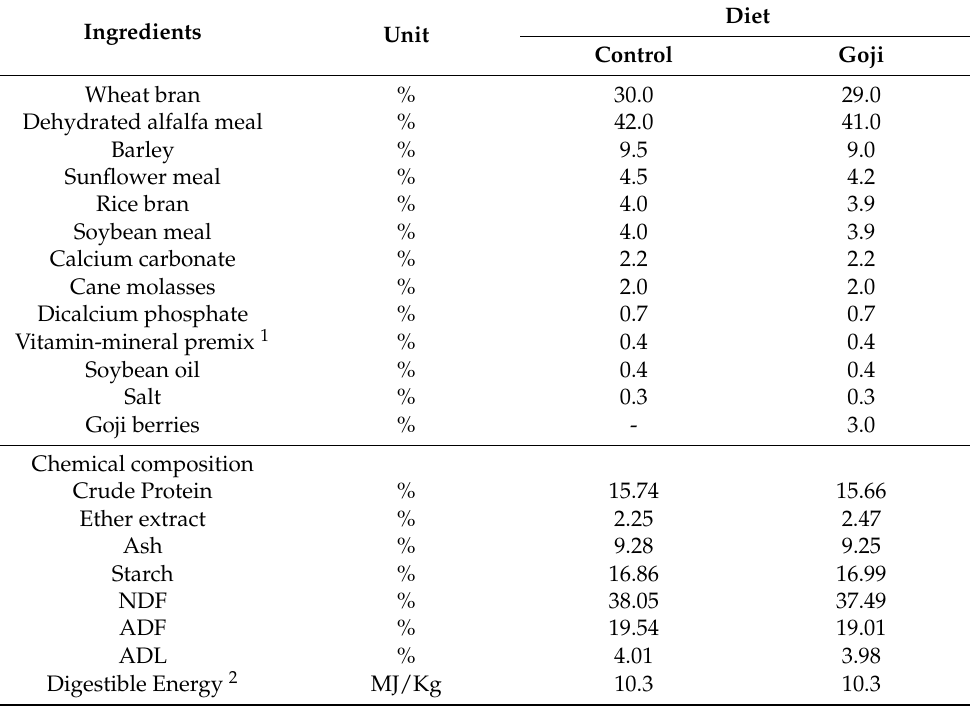
Table 1. Feed formulation and chemical composition (as fed) of control group and Goji group diet.